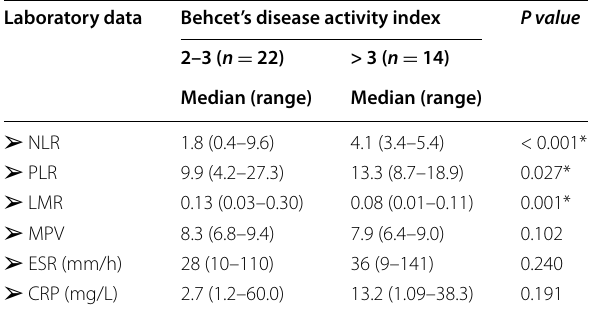
Table 2 Comparison between patients and control groups as regard studied laboratory data